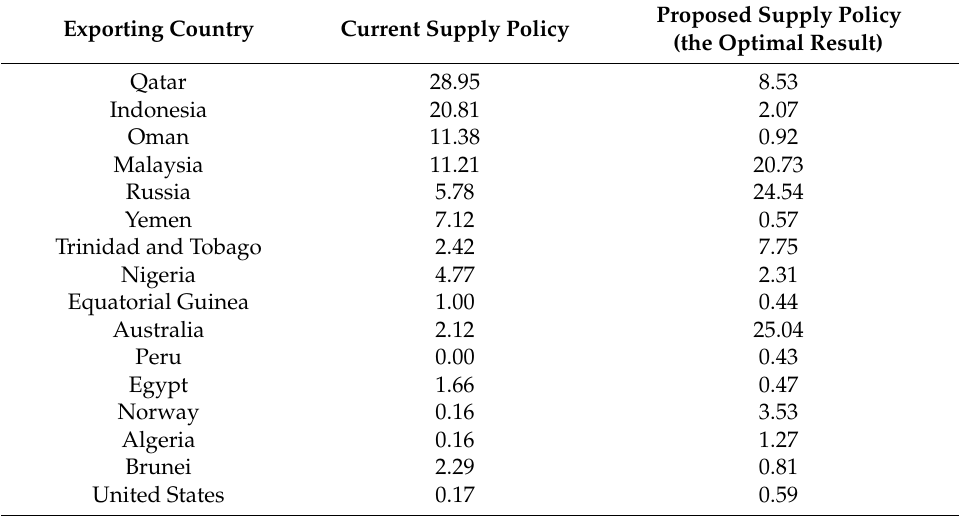
Table 9. Comparison of portfolio analysis results (%).